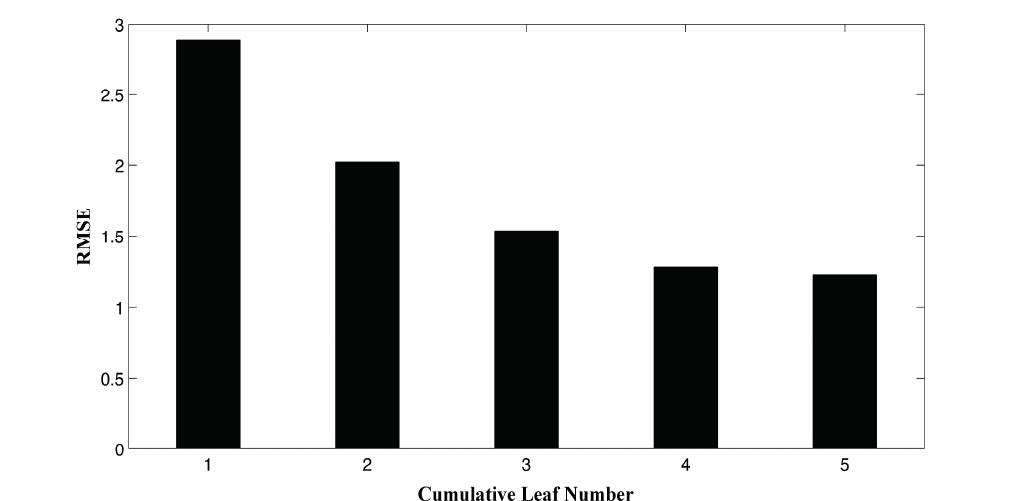
Figure 8. Mean RMSE between the measured canopy spectra and the canopy spectra simulated with PROSPECT+SAILH model for the top one, two, three, four, and five leaves,